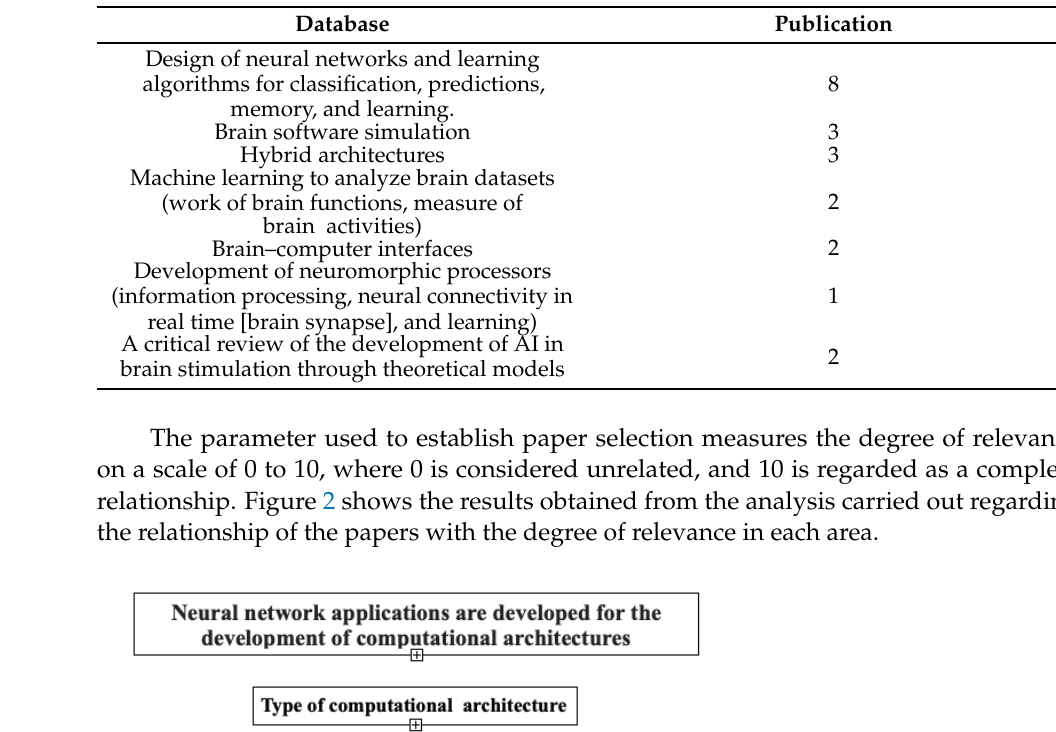
Table 5. Computational architectures in selected publications.